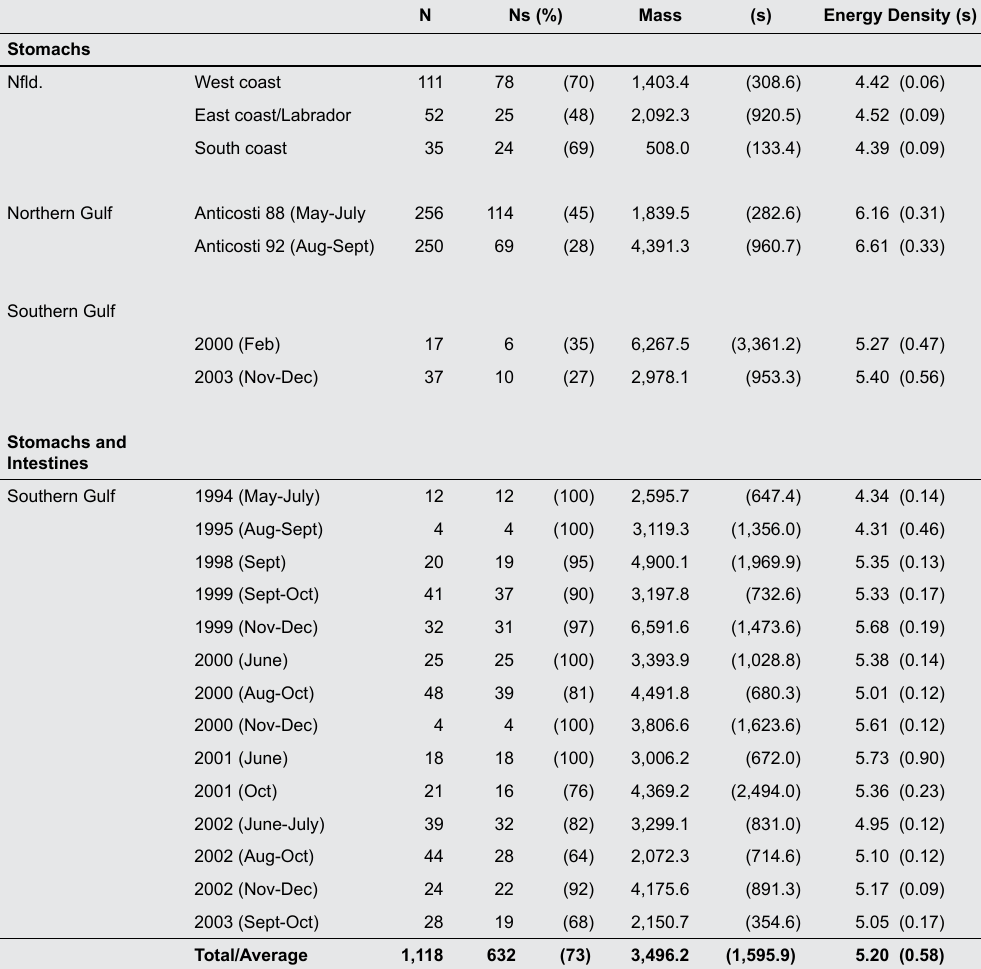
Table 1 . Number of animals collected (N), number of animals with food in digestive tracts (Ns), average reconstructed mass (g) in tract and average energy density (kj/g), with standard devia - tions in parentheses. Samples from Newfoundland, the northern Gulf and southern Gulf (Feb 2000, Nov-Dec 2003) examined stomachs only. The remaining samples from the southern Gulf examined complete digestive tracts. N Ns (%) Mass (s) Energy Density (s) Stomachs